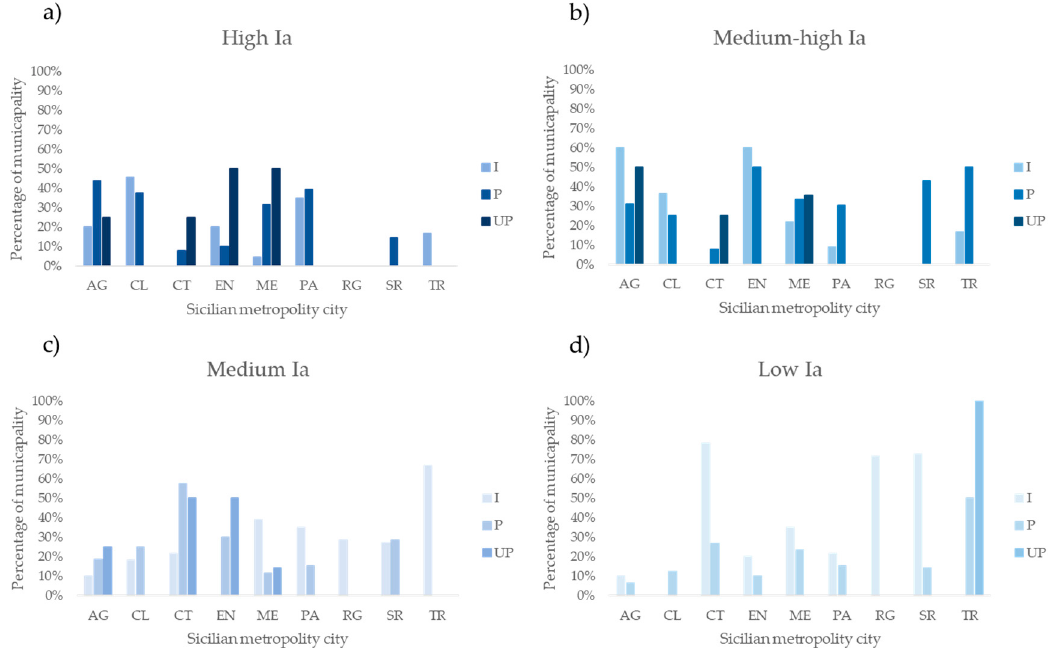
Figure 19. Percentage of municipalities in Sicilian metropolitan cities by classes of abandonment and membership in SNAI internal area types: ( a ) Low I a ; ( b ) Medium I a ; ( c ) Medium-high I a ; ( d ) High I a . (Authors’ elaboration.)